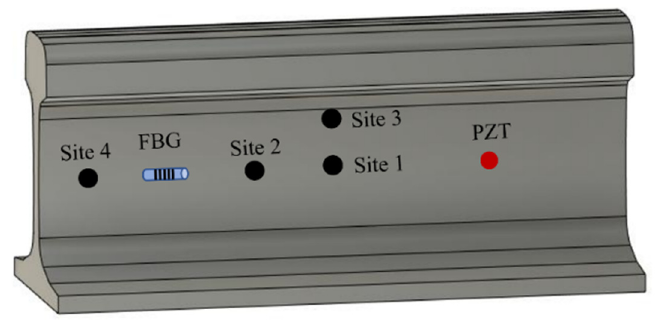
Figure 10. Schematic illustration of the testing specimen and damage location.